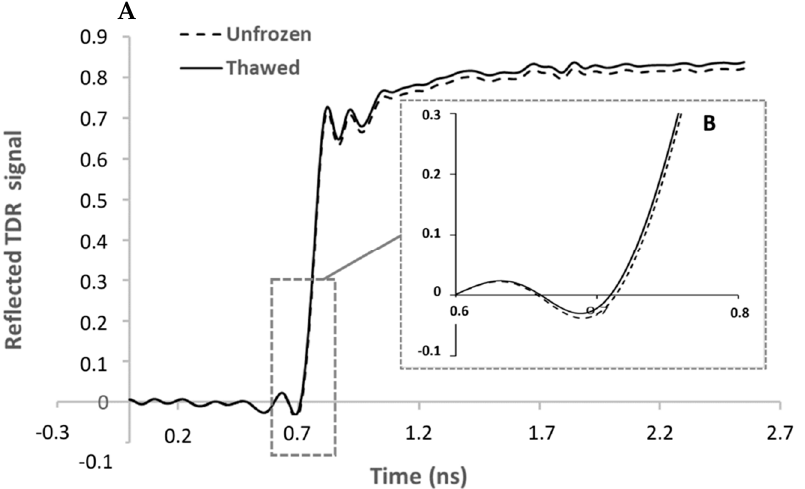
Figure 5. Average value of TDR raw data for unfrozen and thawed samples. ( A ) is the signal of the TDR sensor. ( B ) corresponds with the amplified curve between 0.6 ns and 0.8 ns.